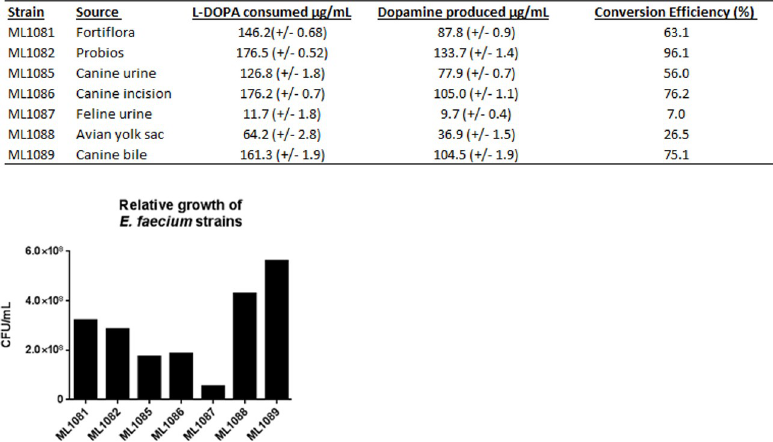
Fig 1. Heterogeneity in dopamine production across varying strains of E . faecium . Strains of E . faecium grown in SIM supplemented with 1mM L-dopa. (Total L-dopa available 179.1 μ g/mL). Top: dopamine production and L-dopa utilization efficacy. Bottom: Population differences between strains. The probiotic strain ML1082 consistently demonstrated the highest level of production at over 133 micrograms/mL. This production was more than 26% greater than the next highest producer, a clinical strain designated ML1086. Both of these strains demonstrated comparable levels of population growth and the consumption of L-dopa appeared to be exhaustive in both of these samples with less than 2% of the starting L-dopa remaining in both samples. Differences in the final dopamine concentrations of these samples appear to arise from differing efficiencies in the conversion of L-dopa to dopamine. ML1082 demonstrated a conversion efficiency of 96%, 20% higher than the efficiency of